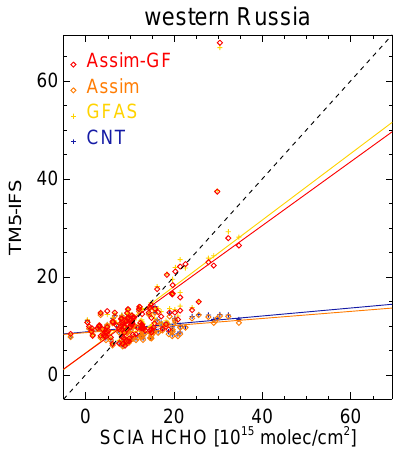
Fig. 16. Scatter plots of mean HCHO columns for model runs at D+0 with respect to observations from SCIAMACHY, for the pe- riod 20 July to 15 August